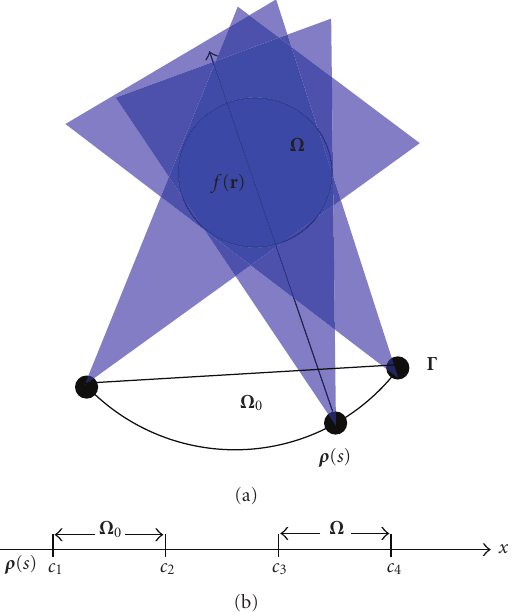
Figure 5: (a) Illustration of nontruncated limited-angle scanning problem; (b) the 1D coordinate system along the X-ray path indicated in